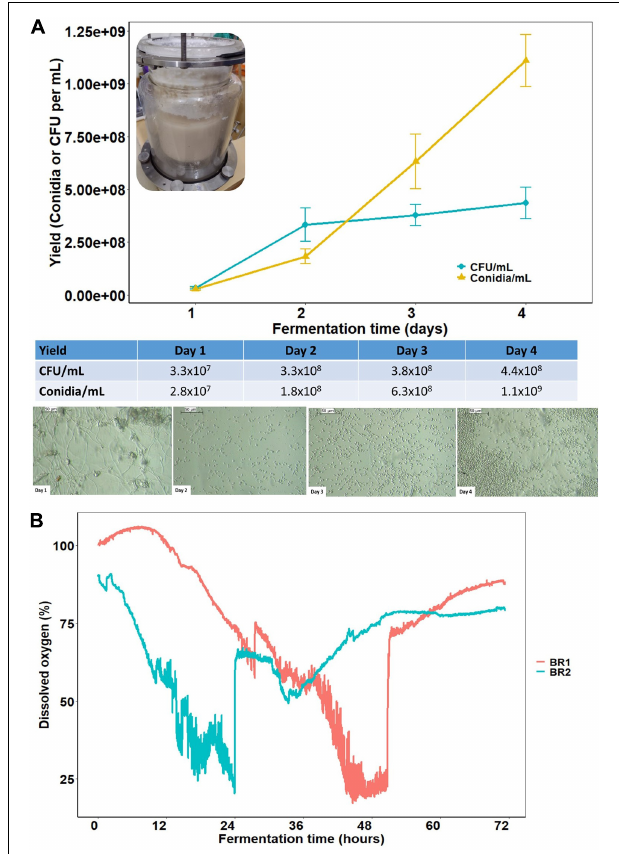
FIGURE 3 | Batch submerged liquid fermentation of C. rosea (strain CMAA1284) carried out in a 3-L benchtop bioreactor using a medium containing dextrose monohydrate, soybean meal and adjusted to 50:1 C:N ratio, 36 g carbon/L and at 28 ◦ C. Evolution of submerged C. rosea submerged conidial production during the first, second, third, and fourth day of fermentation. (A) The yield of submerged conidia and total viable propagules expressed in CFU/ml, and a sequence of microphotographs of submerged conidia production over time. (B) Typical patterns of dissolved oxygen evolution during liquid culture growth of C. rosea in different fermentation